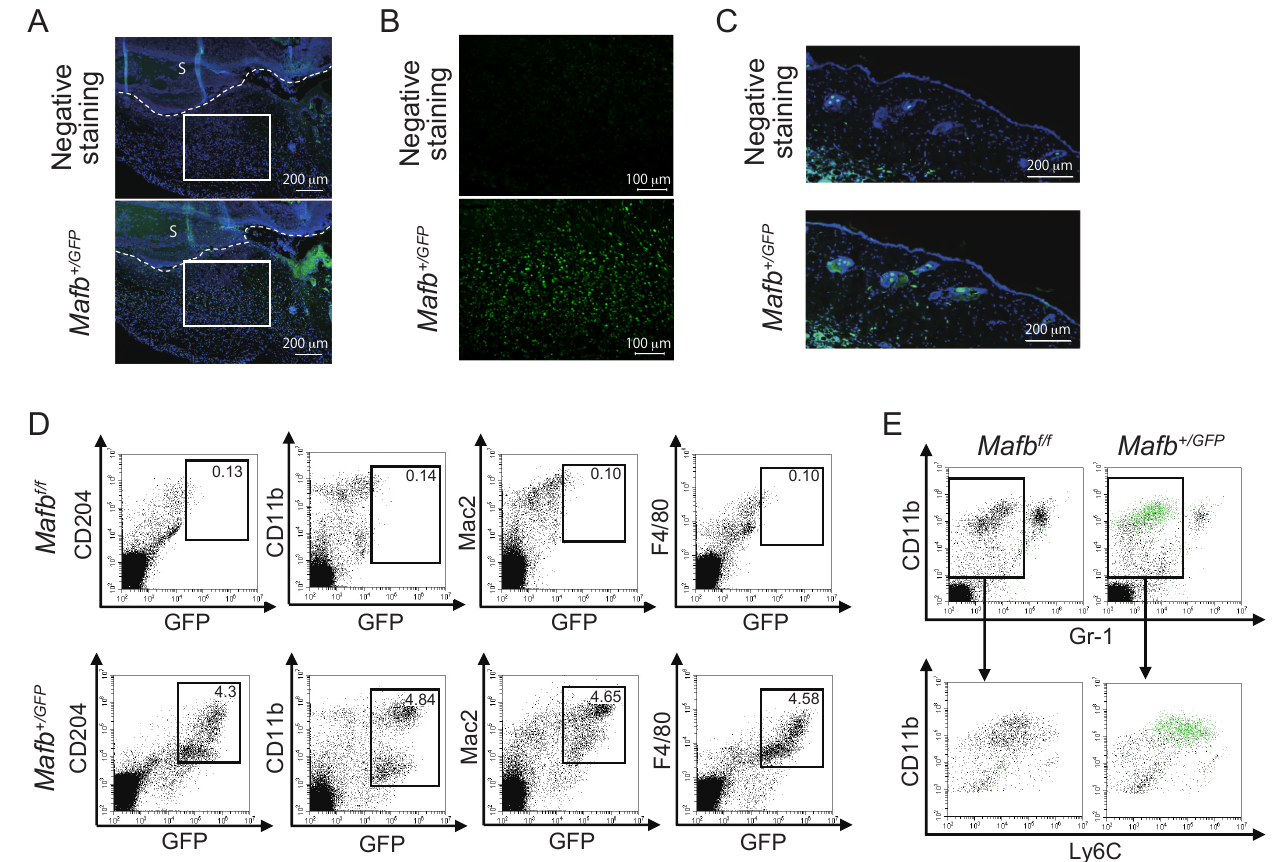
Figure 2. MAFB is expressed in granulation tissue. ( A ) GFP in the day 3 wounds of Mafb +/GFP mice was immunostained and observed under a microscope at × 100 magnification. ( B ) Granulation tissue enclosed in the square in ( A ) was observed at × 200 magnification. ( C ) GFP expression in the dermis was observed in same tissue as in A. ( D ) Macrophages in the day 3 wounds of Mafb +/GFP mice were stained with CD204, CD11b, Mac2, and F4/80 and analyzed using flow cytometry. ( E ) GFP-expressing cells (green dots) in the day 3 wounds are shown. Each experiment used n = 2–4 Mafb +/GFP mice. Representative data are